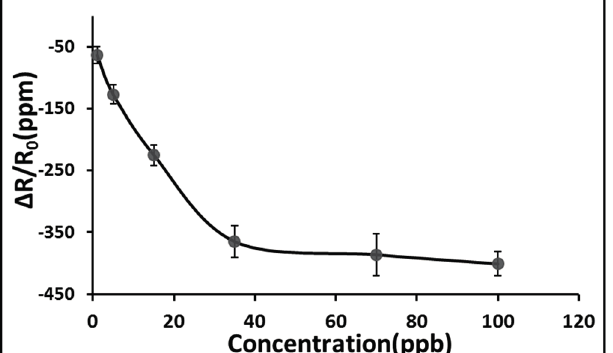
Figure 7. Resistance changes of the sensor at various NO concentrations using dry nitrogen as carrier gas at room temperature.